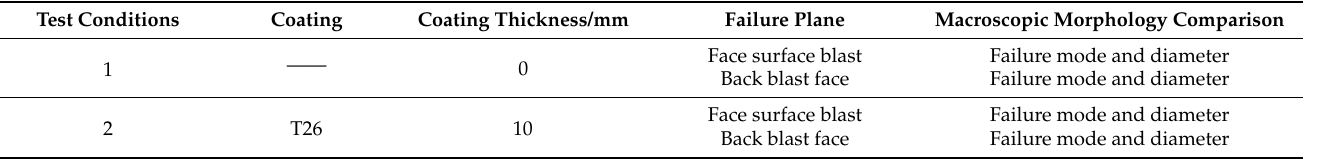
Table 3. Comparison analysis method of macroscopic morphology.